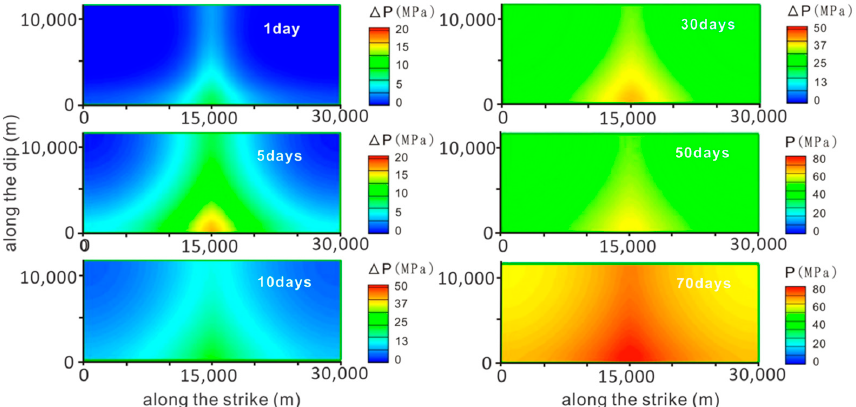
Figure 4. The distribution of increasing pore pressure at different times during the fluid intrusion.